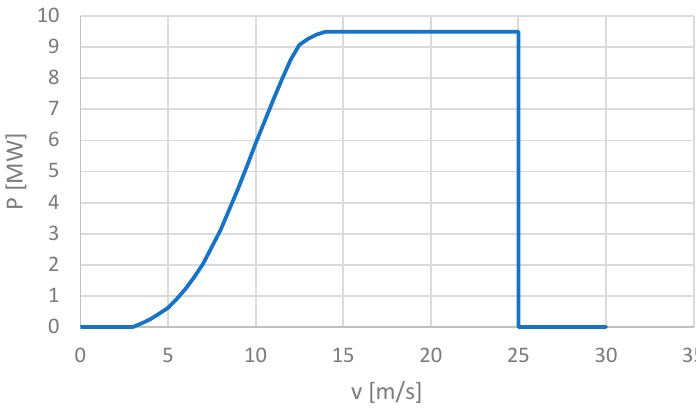
Figure 1. Power characteristics of the V164-9.5MW turbine. Equation (5) was used to calculate the annual energy E produced by the turbine [9]. The number of hours in year T in the analyzed period was on average 8766.4 h (4 leap years in the analyzed 15 years).